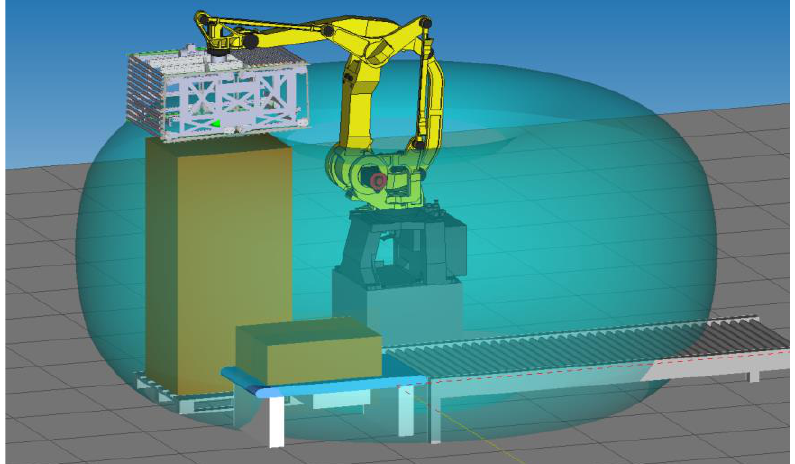
Figure 12. The working range of the roller gripper on the robot.